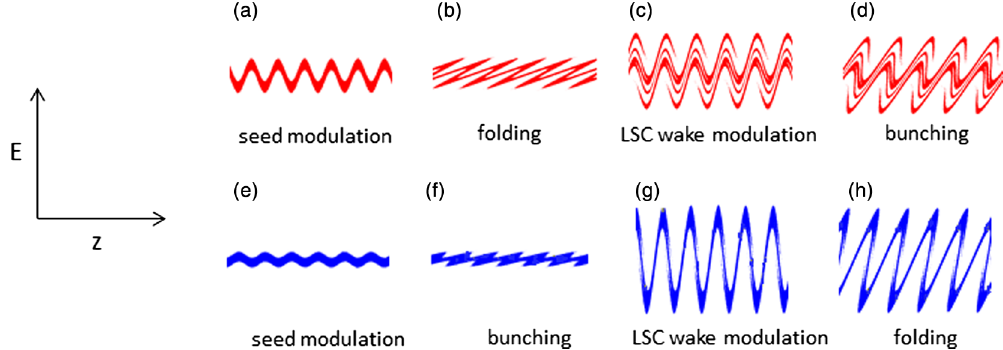
FIG. 3. Longitudinal phase space of LSC-EEHG seeded (a) – (d) and lasing suppressed (e) – (h) electron beam slices at different stages of the seeding process. Although two-color seeds are used in subsequent simulations, the simpler case of a single seed modulation wavelength was used here to illustrate the